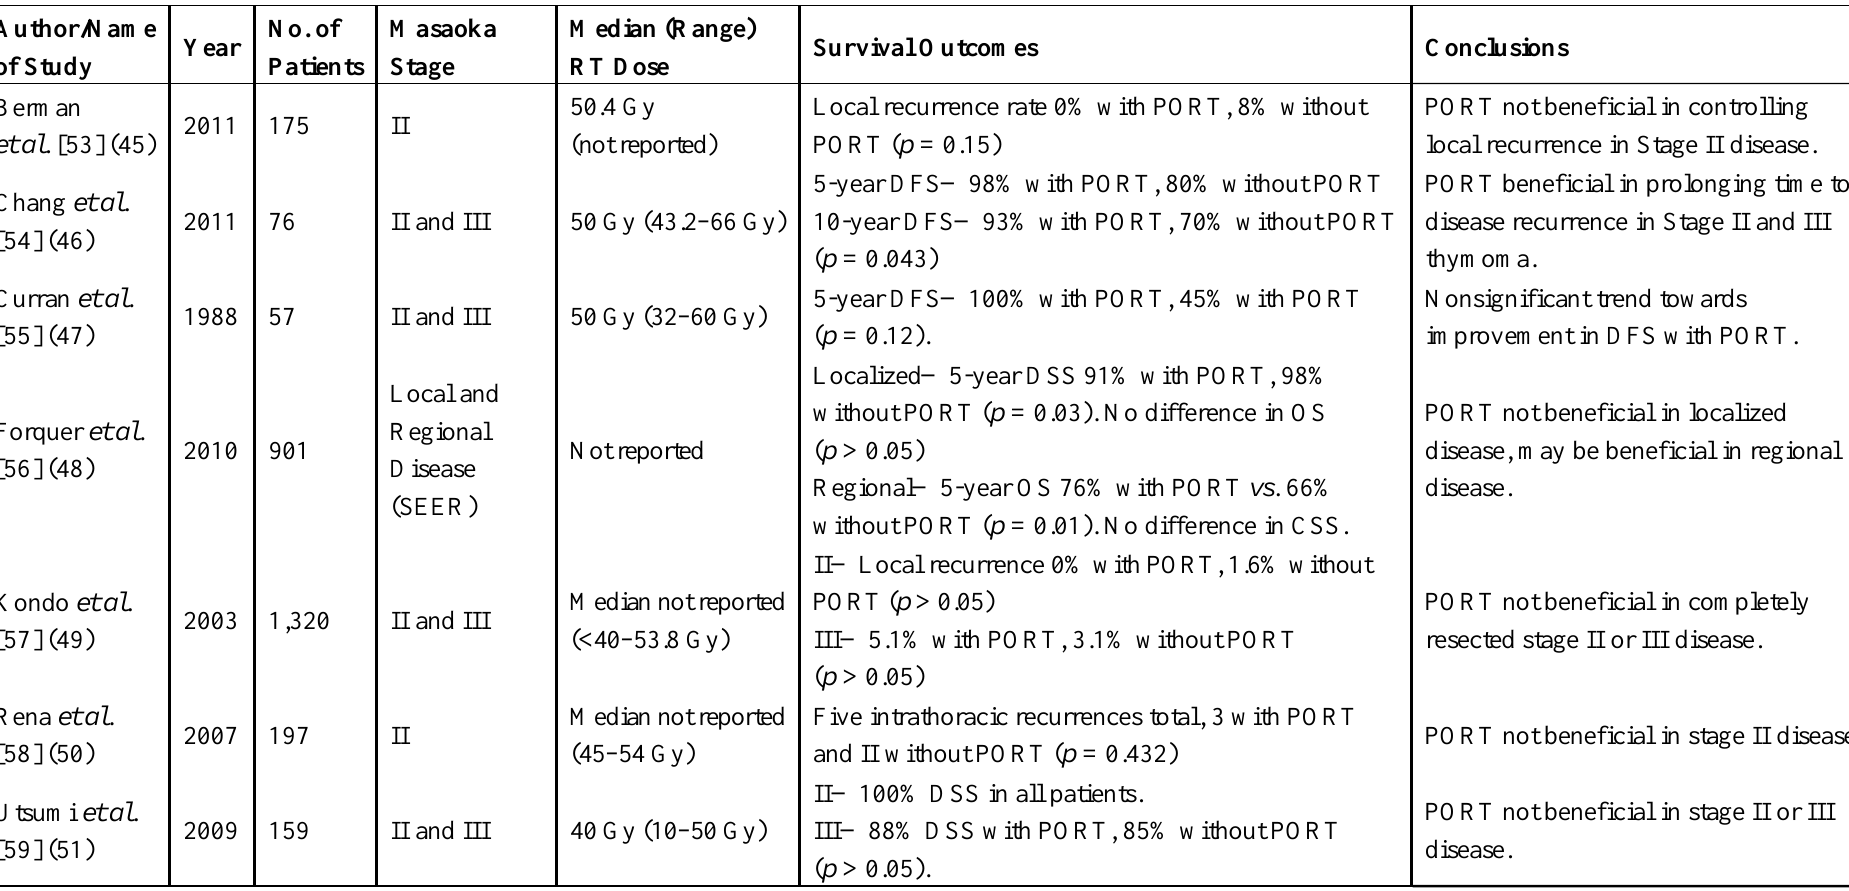
Table 3. Selected clinical trials of postoperative radiation therapy for stage II and III